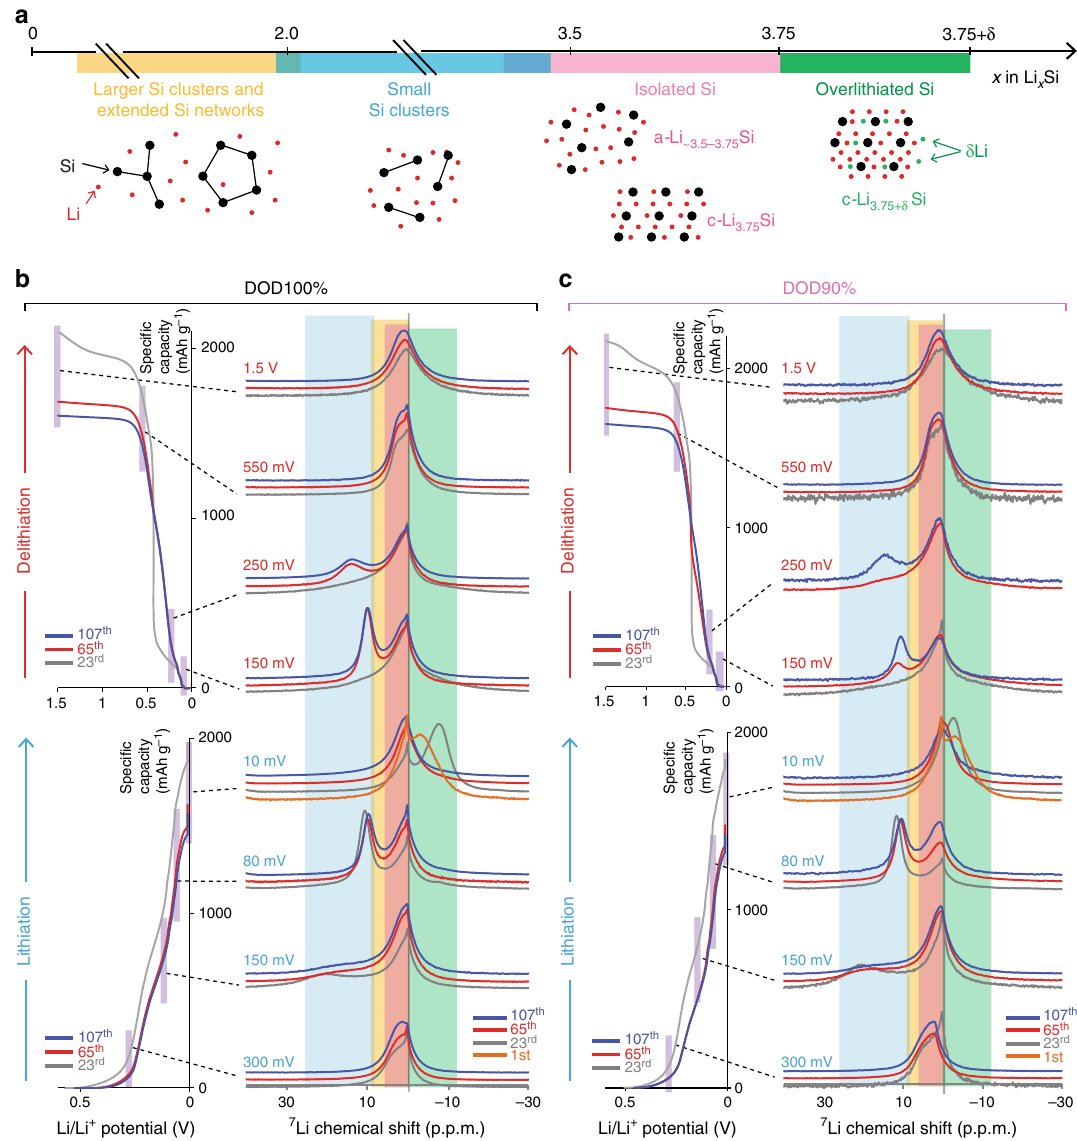
Fig. 7 Ex situ MAS 7 Li solid-state NMR spectra at various (de)lithiation potentials. a Schematics of various Li – Si local environments as a function of Li concentration in Li – Si alloys. The 7 Li resonances are highlighted by yellow (10 – 0 p.p.m., larger Si clusters and extended Si networks), blue (25 – 10 p.p.m., small Si clusters), pink (6 – 0 p.p.m., isolated Si 4 − anions including c-Li 3.75 Si), and green (0 to − 10 p.p.m., overlithiated crystalline phase, c-Li 3.75+ δ Si). The notations for the Li – Si environments and their correlation with the Li – Si electrochemical processes are also summarized in Supplementary Table 5. The recorded spectra at various Li/Li + potentials over 107 cycles at the probing points under ( b ) depth of discharge (DOD)100% and ( c ) DOD90%. The NMR spectra at each potential are linked to the corresponding points in the capacity – voltage pro fi les. Orange, gray, red, and blue solid lines correspond to the spectra at the 1 st , 23 rd , 65 th , and 107 th cycles, respectively. The spectra for different cycle numbers and different potentials are stacked with constant pitch to show the different processes more